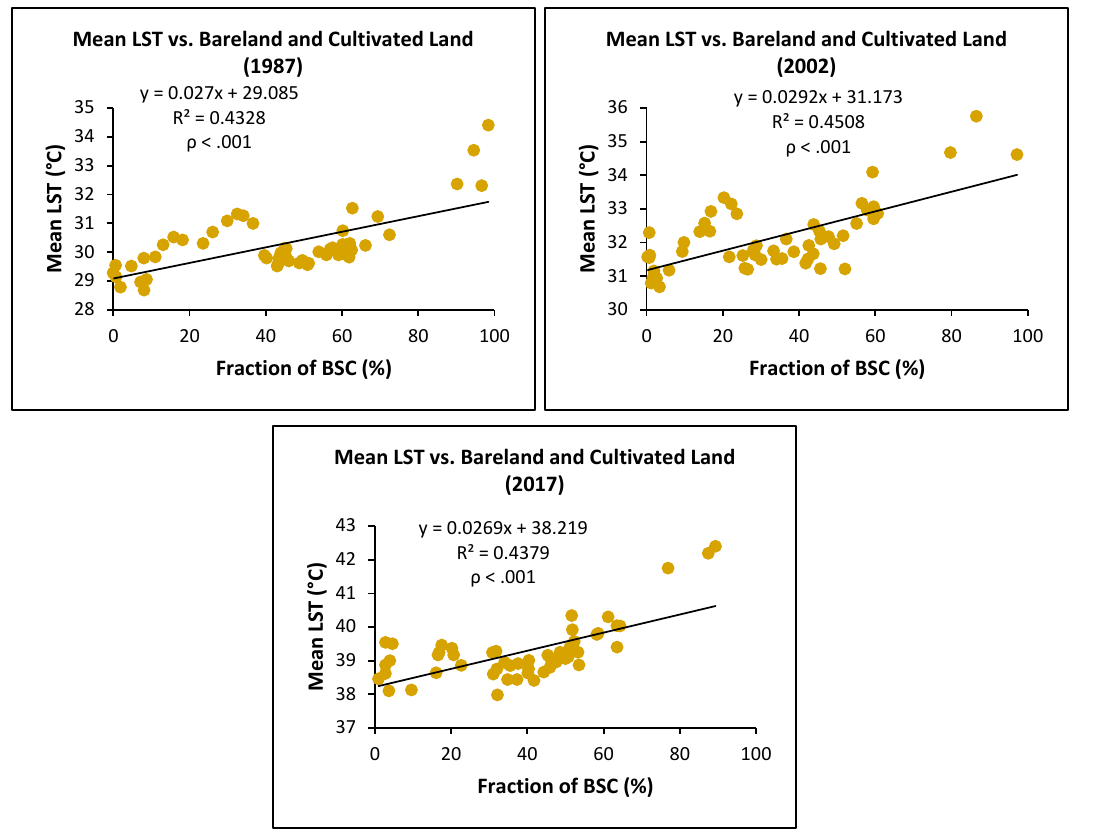
Figure 8. Scatter plots and statistical relationships (baresoil and cultivated). 3.3. Impervious Surface, Green Space and Baresoil and Cultivated vs. LST at Multiple Resolution Across grid sizes in Seville City, the correlation is stronger between mean LST, green space and baresoil and cultivated density than between mean LST and impervious surface density over the three years. From this three-year analysis, the strongest correlation between mean LST and green space density occurred in 1987, while 2002 was the year with the strongest correlation between mean LST and baresoil and cultivated land. In the case of impervious surface density, this correlation occurred in 2002 and 2017, with both being very similar (Figures 9 and 10).